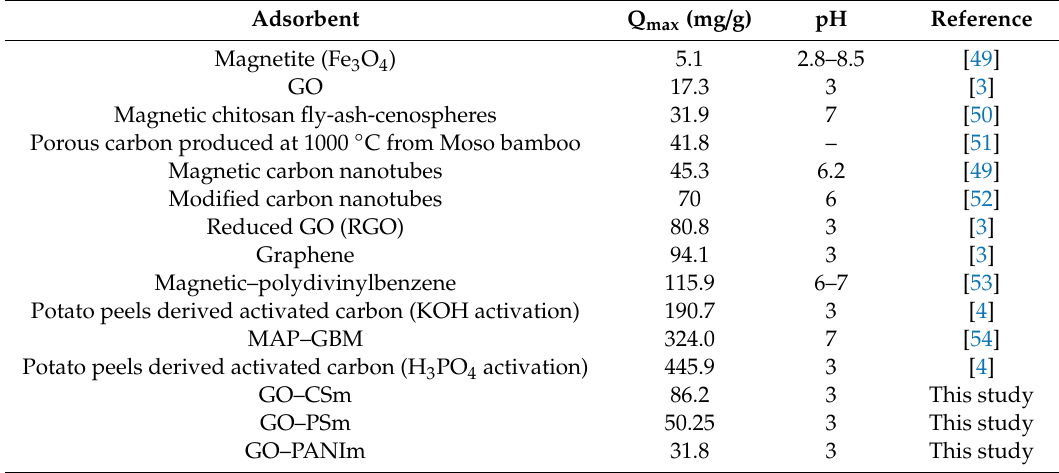
Table 4. Comparison of BPA adsorption on Mag-PVP with other adsorbents.